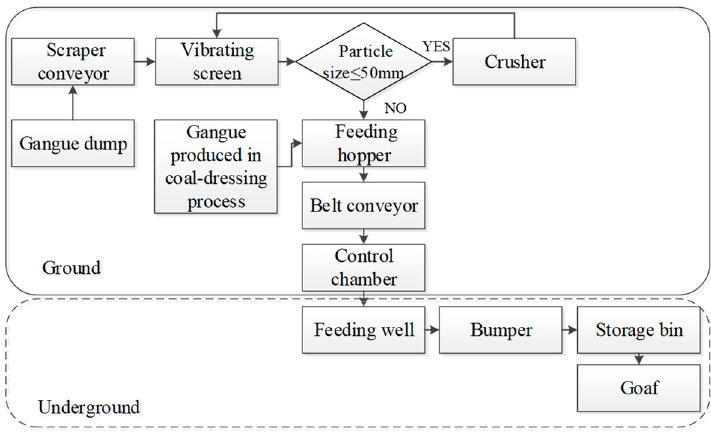
Figure 9. Backfilling process of granular backfill materials.